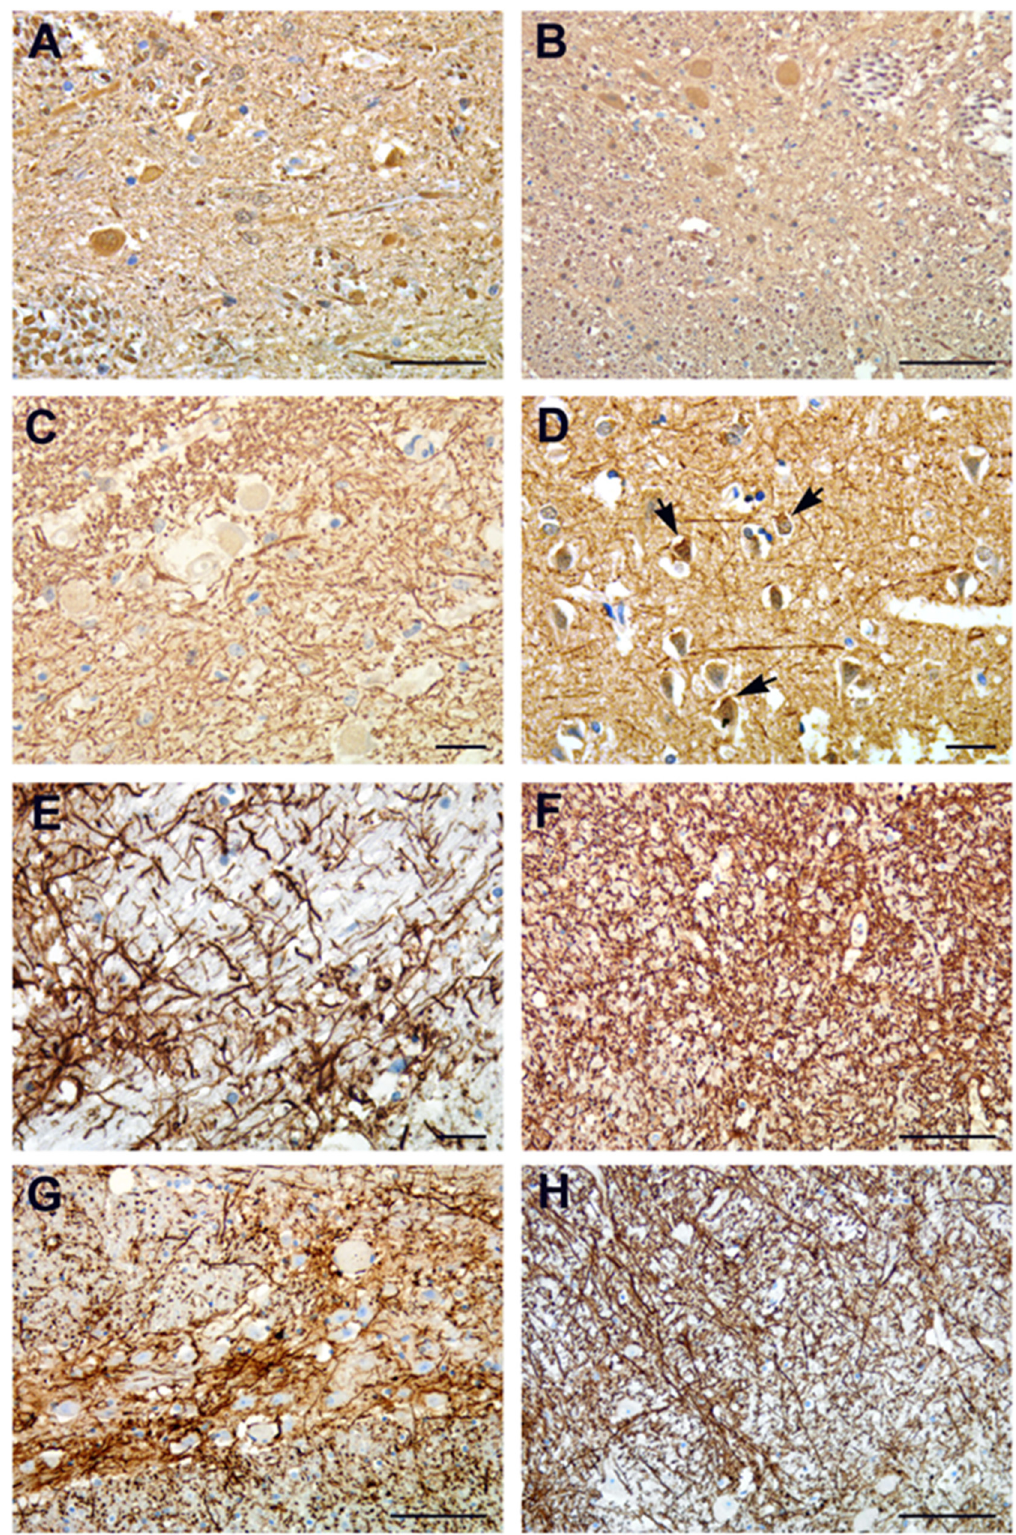
Figure 4. Neurofilament and GFAP immunohistochemistry. ( A – C ) Neurofilament protein immunohistochemistry shows neuron’s feltwork (neuropil) creating a chaotic meshwork with smaller dot-like structures. ( D ) Vacuolized and piknotic neurons (arrows). ( E ) Pathologic reactions of astrocytes highlighted by GFAP immunoreactivity showing fibrillary gliosis. ( F – H ) GFAP immunoreactivity showing granular bodies and dense filamentous deposits. Astrocytic gliosis is particularly evident in the pons ( F ), medulla oblongata ( G ) and spinal cord ( H ) associated with swollen neurons. Images from patients who did not have previous neurological deficits. Scale bars: ( A , G ) = 50 μ m; ( B , F , H ) = 100 μ m; ( C , D , E ) =14 μ m.